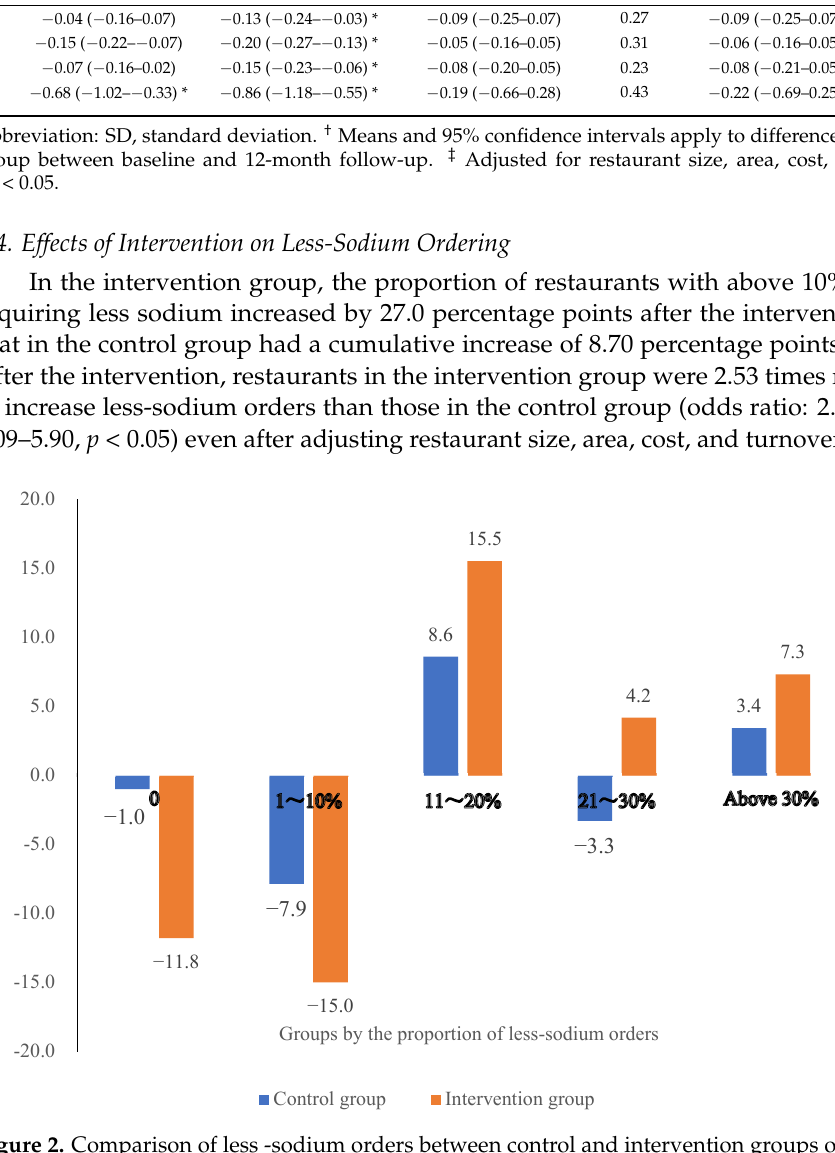
Figure 2. Comparison of less -sodium orders between control and intervention groups of restaurants before and after the intervention.